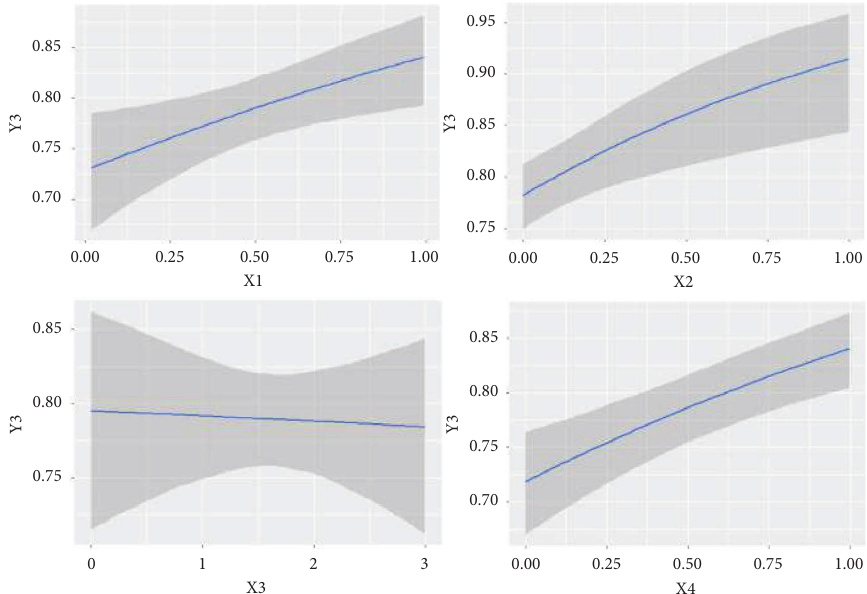
Figure 2: Te marginal efects of the risk factors in the advanced stage of prostate